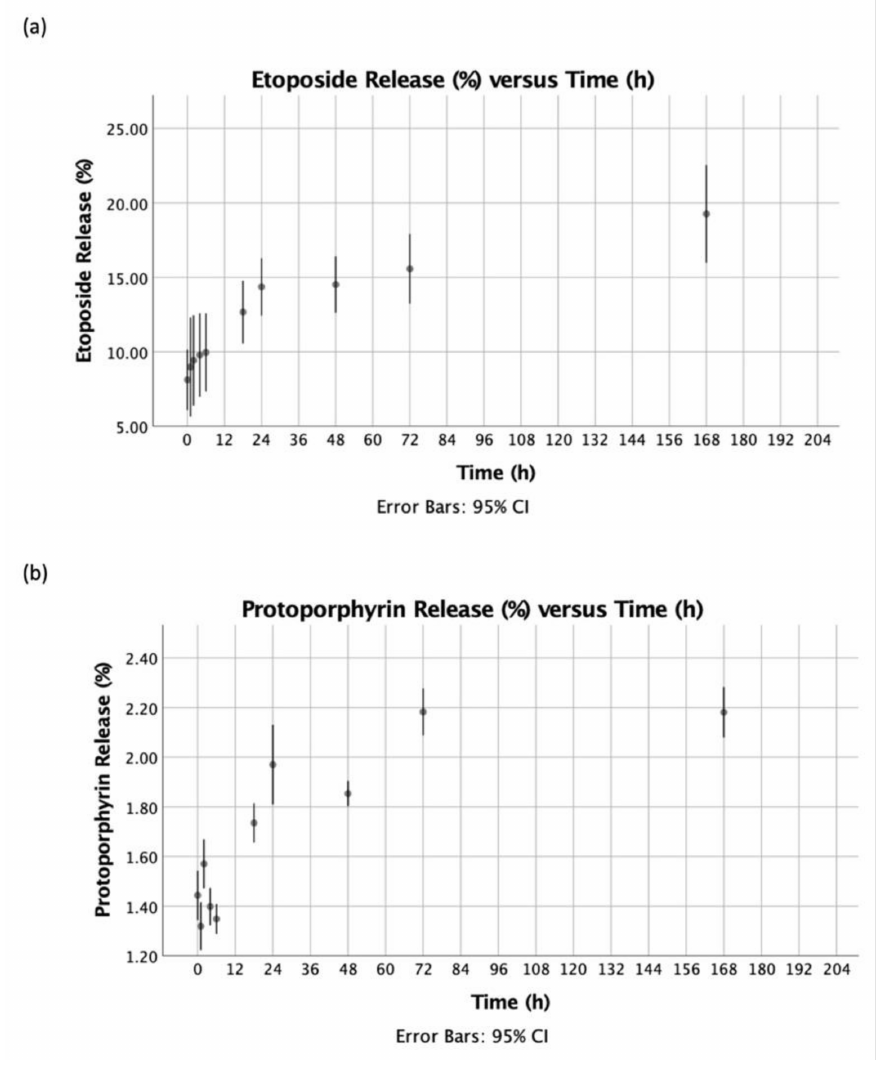
Figure 3. The release of Etop and PpIX from Etop/PpIX-PAMAM(G5) Ns was determined by absorbance spectroscopy. ( a ) The release profile of Etop; at time zero, 8.1 ± 3.0% of free Etop appeared to exist with the Etop/PpIX-PAMAM(G5) Ns. The release of Etop was observed up to 3 days (15.6 ± 3.5%), which then stopped from days 3 to 7. Only 19.3 ± 4.6% of free etoposide was found at day 7. ( b ) The release profile of PpIX; at time zero, 1.4 ± 0.2% of free PpIX was detected, which also rose within the first 3 days (2.2 ± 0.1%), and stopped from days 3 to 7. The percentage of free PpIX at day 7 remained unchanged. n = 8. (Etop—etoposide, PAMAM(G5) Ns—generation-5 polyamidoamine dendrimer nanosphere, PpIX—protoporphyrin